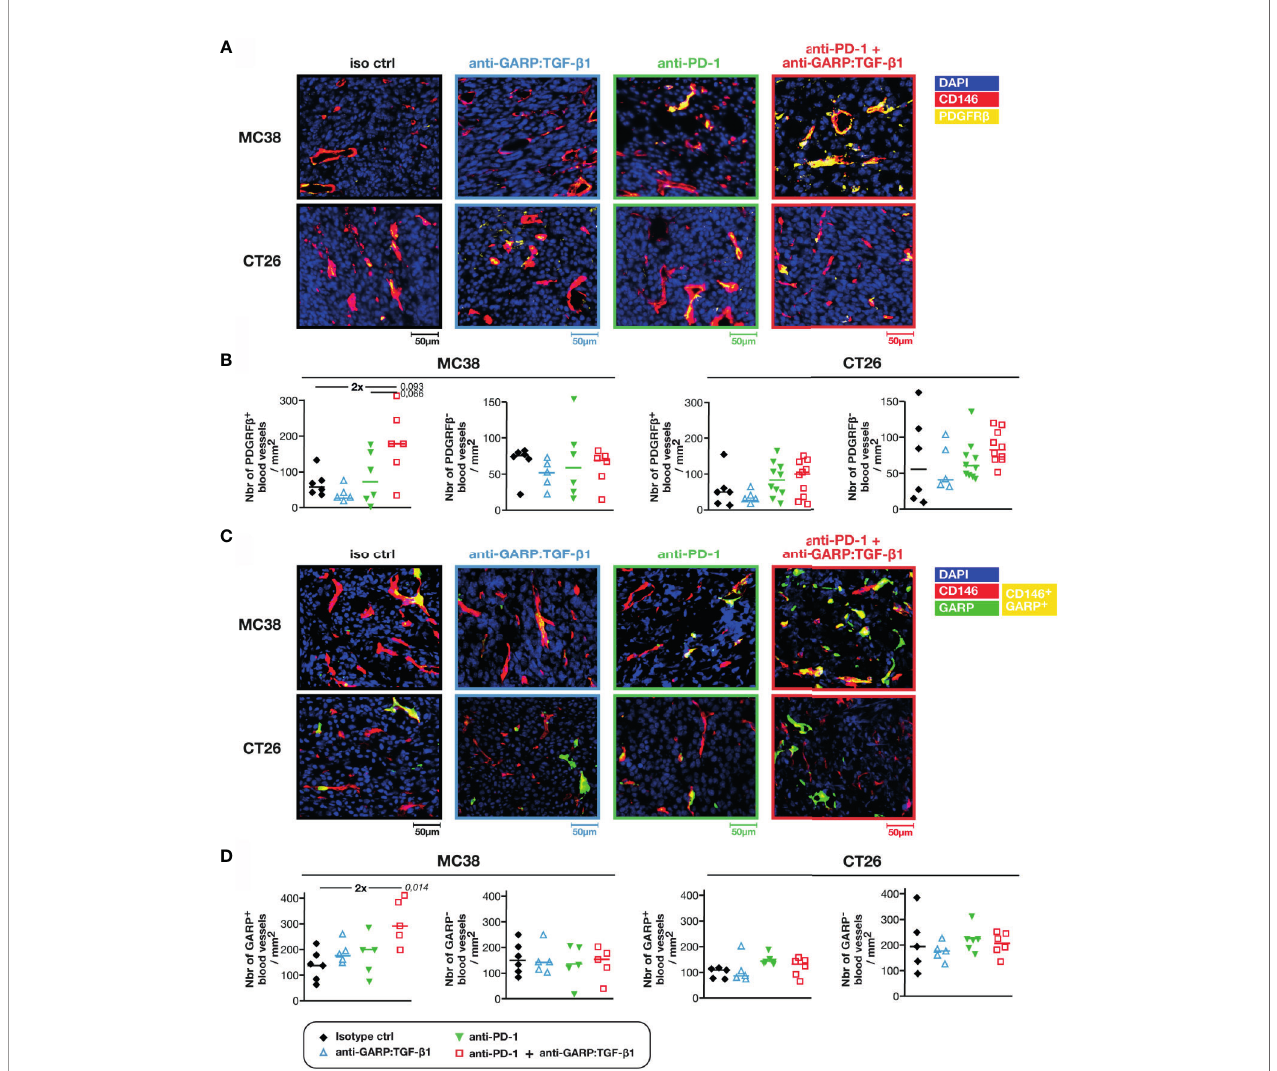
FIGURE 4 | Combined GARP:TGF- b 1/PD-1 blockade increases the density of intratumoral GARP + blood vessels covered by pericytes in MC38, but not in CT26 tumors. Additional FFPE and frozen tumor sections obtained from mice in Figures 1A, B were analyzed by mIF and quantitative digital imaging. (A, B) Representative images (A) and quanti fi cation (B) of PDGFR b + and PDGFR b - blood vessels ( i.e. CD146 + PDGFR b + and CD146 + PDGFR b − objects) in FFPE tumor sections stained with anti-CD146 (red), anti-PDGFR b (yellow) and Hoescht (DAPI, blue). (C, D) Representative images (C) and quanti fi cation (D) of GARP + and GARP - blood vessels ( i.e. CD146 + GARP + and CD146 + GARP − objects) per mm 2 of frozen tumor sections stained with anti-CD146 (red), anti-GARP (green) and Hoescht (DAPI, blue). GARP + vessels appear in yellow. Data points represent values in individual mice. Horizontal bars: median per group. P values <0.05 are indicated in italics (calculated with a two-sided Wilcoxon test). Numbers in bold: fold-change between the indicated groups. One tumor section analyzed per